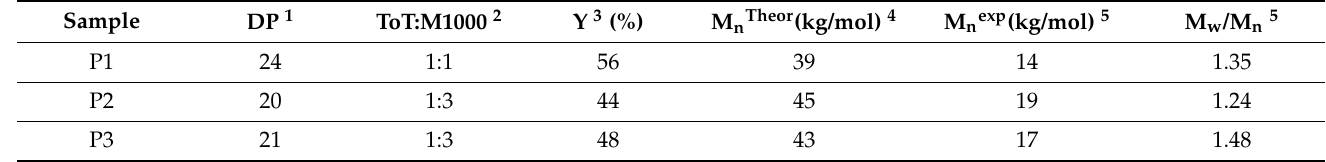
Table 1. Composition, yield and molecular weight of polymers